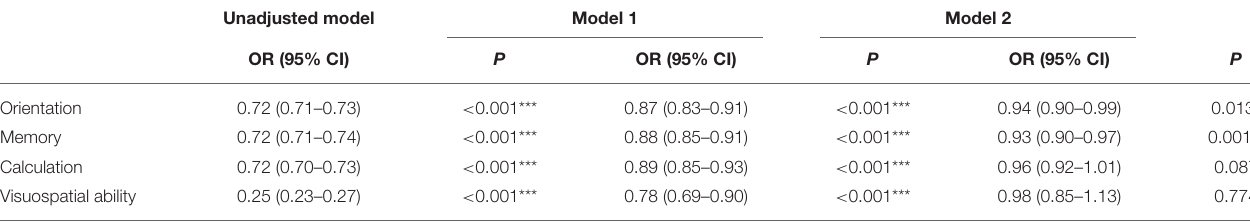
TABLE 5 | Logistic regression analysis of the four cognitive domains and subsequent falls ( n = 5,110).